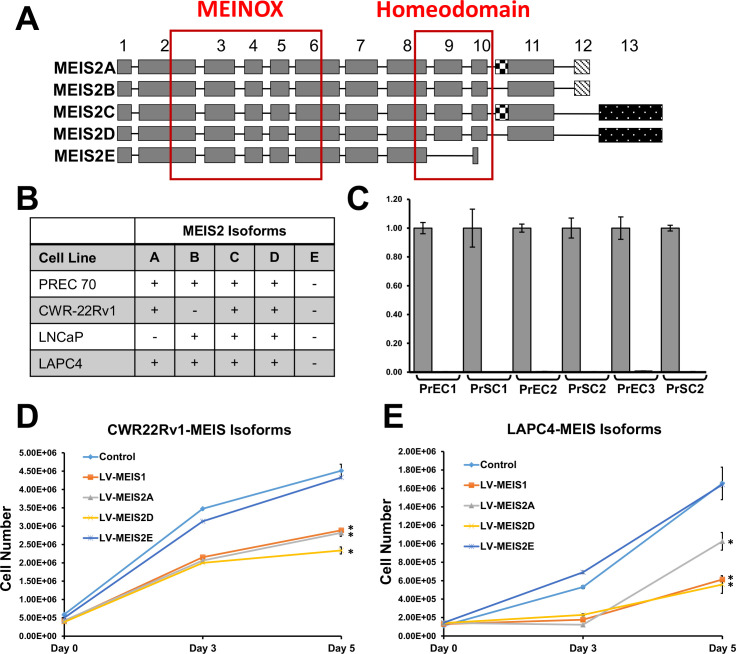
MEIS2 Isoforms in Prostate Cancer Cells.(A) Schematic indicating the most common translational isoforms of MEIS2 (UniProt Identifier #O14770) modified from Geerts et al., 2005. Boxes represent exons as numbered on top. The checkered box represents the extra sequence within variant exon 11, and exons 12 and 13 are mutually exclusive. The two main functional domains, Meinox and Homeodomain, are boxed off in red. (B) Isoform distribution of MEIS2 in prostate cells. Table represents presence or absence of each MEIS2 isoform A through E identified in at least 5% of MEIS2 transcripts. (C) Absence of detectable MEIS2E isoform in primary prostate epithelial cells (PrECs) and stromal cells (PrSCs) obtained from three different patients. (D and E) Lentiviral expression and growth suppression of MEIS1, MEIS2A, and MEIS2D isoforms (LV-MEIS1, 2A, and 2D) in CWR22Rv1 and LAPC4 prostate cancer cells. Data for Control, MEIS1, and MEIS2A are also shown in Figure 1. The MEIS2E isoform, which lacks a DNA-binding homeodomain, did not suppress cell growth.